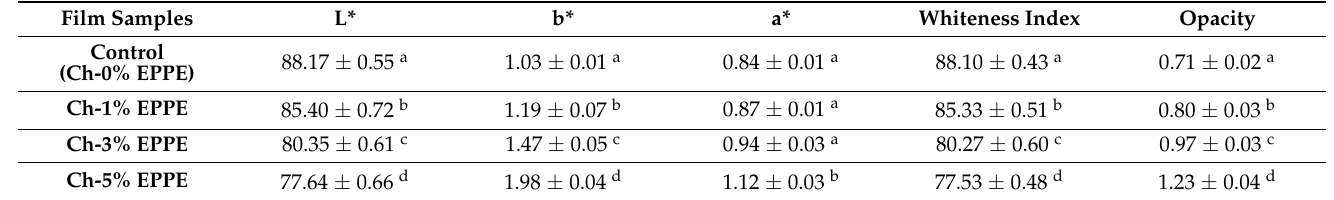
Table 2. Colour parameters and optical index of chitosan films modified with different percentages of